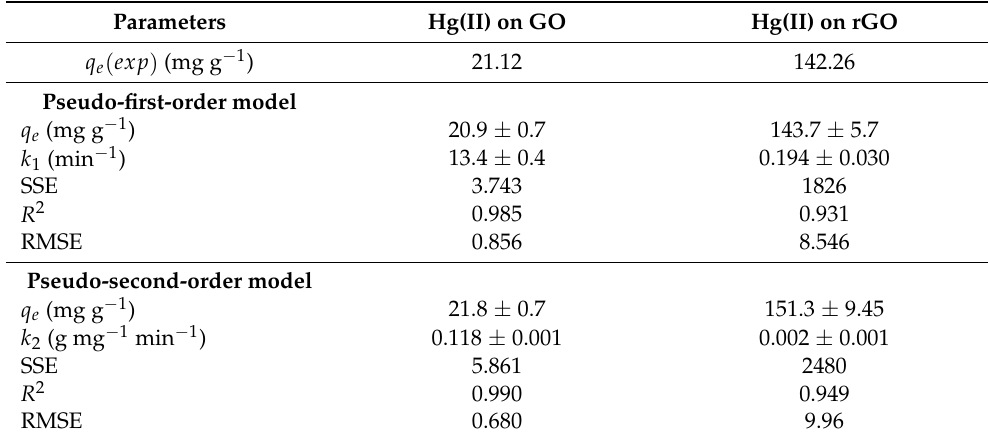
Table 2. Parameters of pseudo-first-order and pseudo-second-order models are estimated at 298 K.